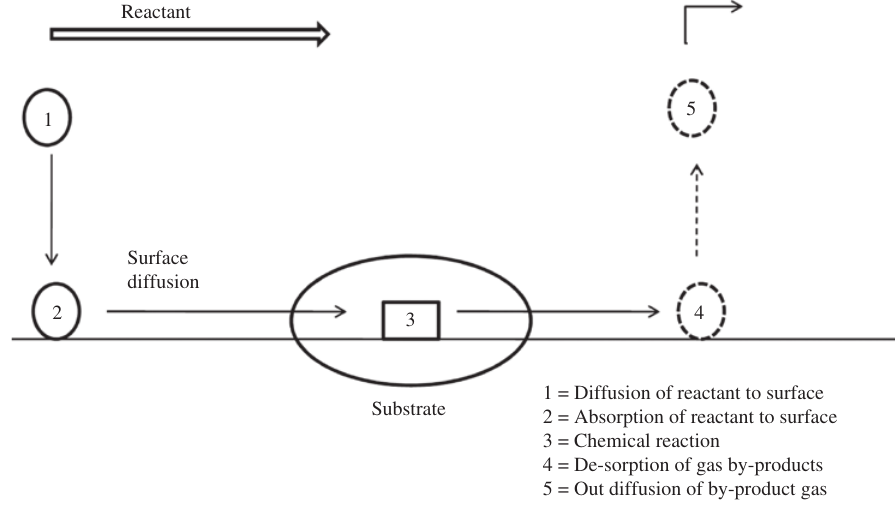
Figure 23: Mechanism of CVD.